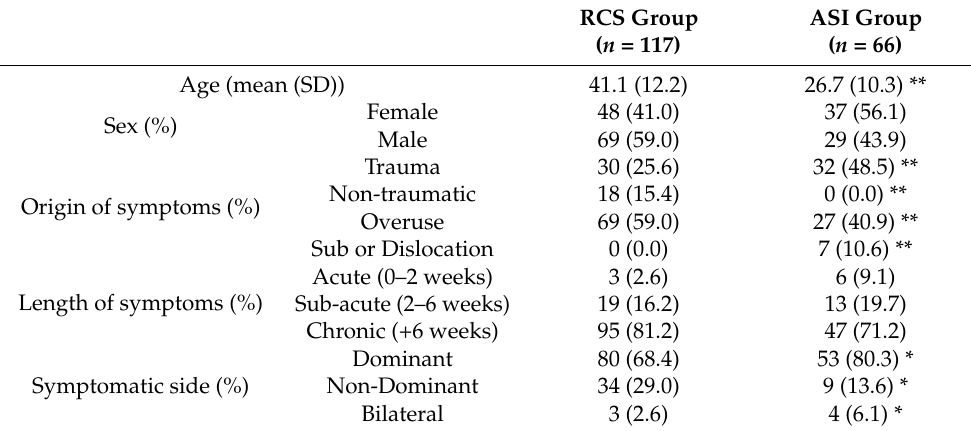
Table 1. Patient